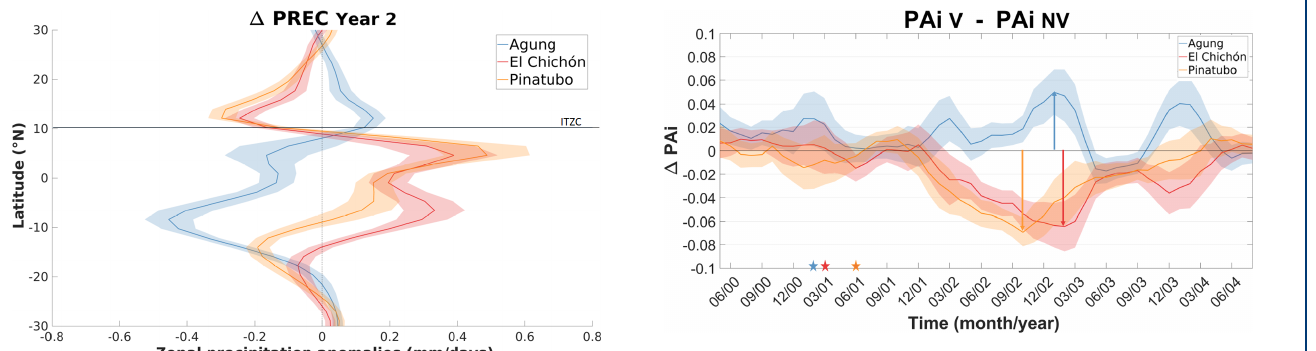
Figure 7. Evolution of the difference in the ensemble mean be- tween the precipitation asymmetry index (PAi) after each eruption (PAi V ) and the climatology (PAi NV ). Shading represents twice the standard error of the ensemble mean (i.e. ∼ 95% confidence inter- val). The three stars represents the moment of each